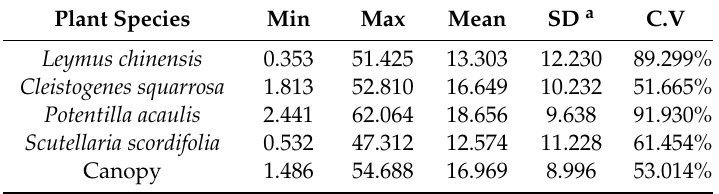
Table 1. Dust retention content range in g / m 2 shown for each plant species and the canopy. Plant Species